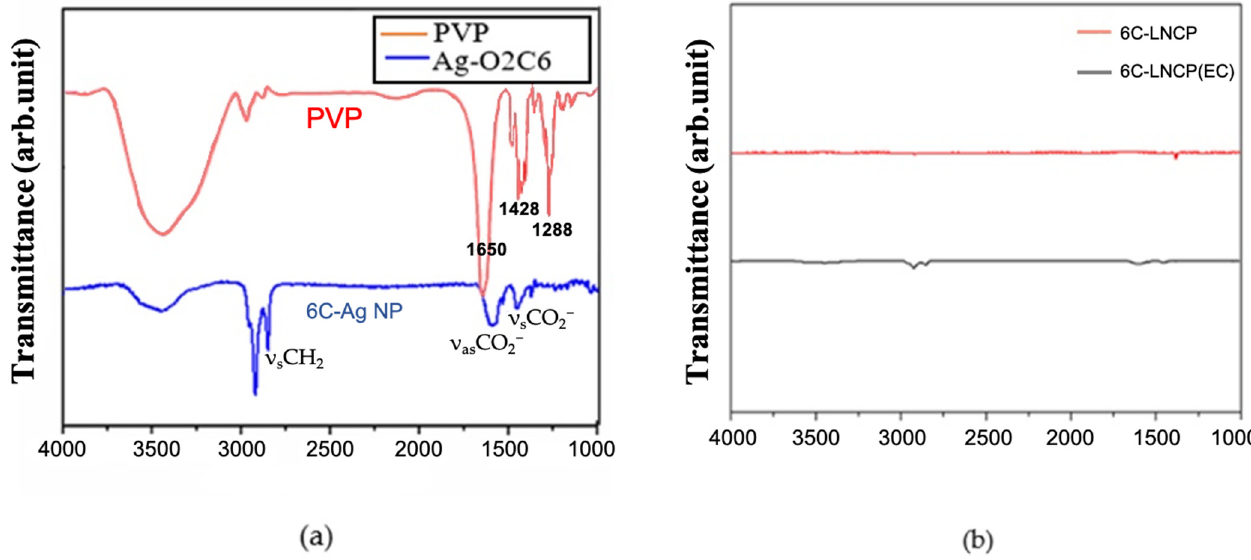
Figure 6. FT-IR spectra: ( a ) PVP (red) and Ag-6CO12 (blue) nanoparticles and ( b ) 6C-LNCP (red) and 6C-LNCP (black) after sintering.